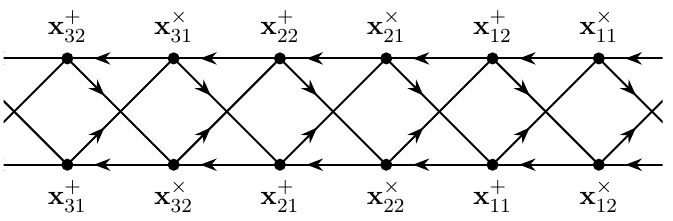
Figure 11 . Quiver for (3 ; 2) case represented in ‘triangular’ form.